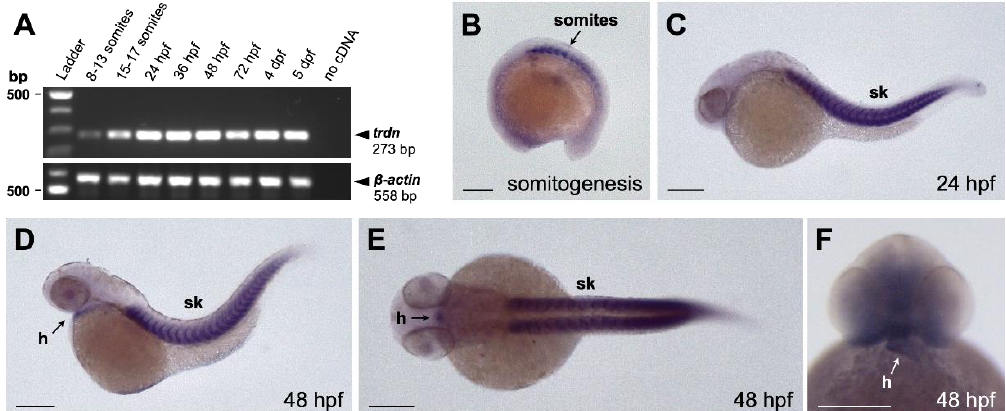
Figure 1. Expression analysis of trdn in zebrafish embryo. ( A ) RT-PCR performed on RNA isolated from zebrafish embryos at different developmental stages. β-actin was used as the loading control. ( B – F ) WISH analyses with a trdn -specific probe in zebrafish embryos. trdn is expressed in skeletal muscles and heart. ( B – D ) Lateral view of a 13 somite ( B , anterior to the left), 24 hpf ( C ) and 48 hpf ( D ) embryos. ( E , F ) Dorsal ( E ) and frontal ( F ) view of a 48 hpf embryo. Scale bars indicate 100 μm. sk, skeletal muscle; h, heart.